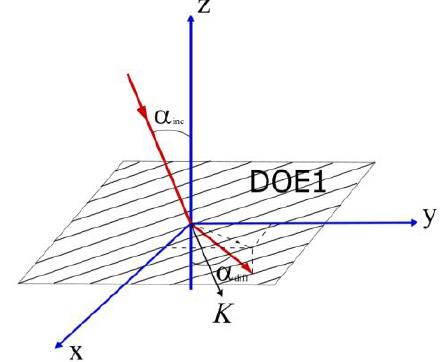
Figure 7. The scheme of radiation diffraction on the DOE.